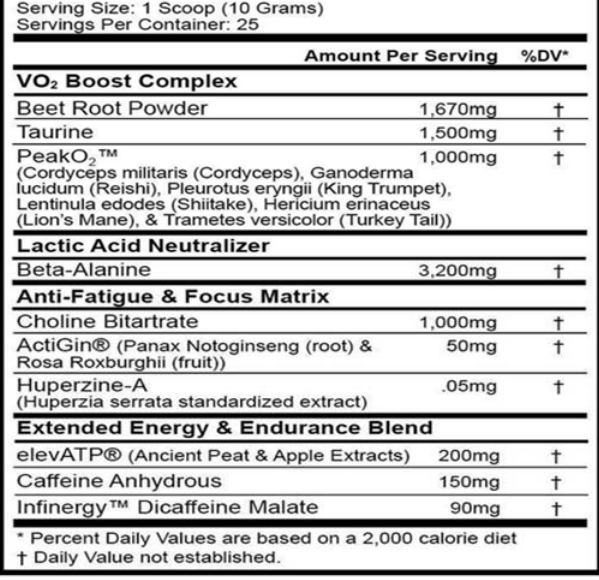
Figure 1. Supplement label information for the PerformElite™.